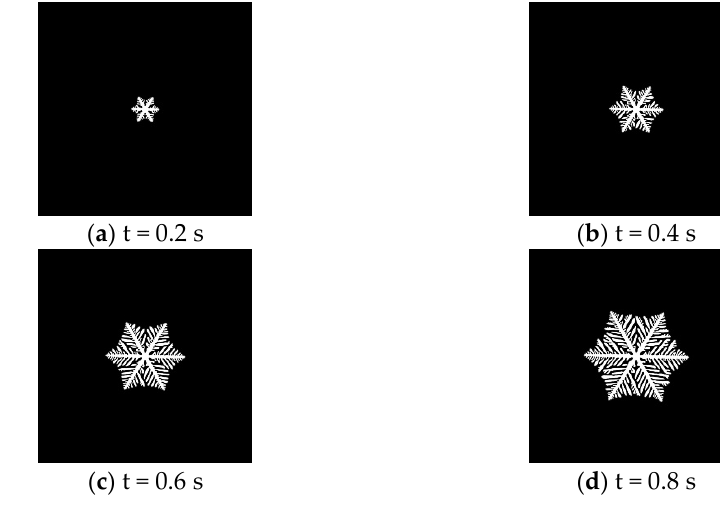
Figure 9. PF of snowflake growth.